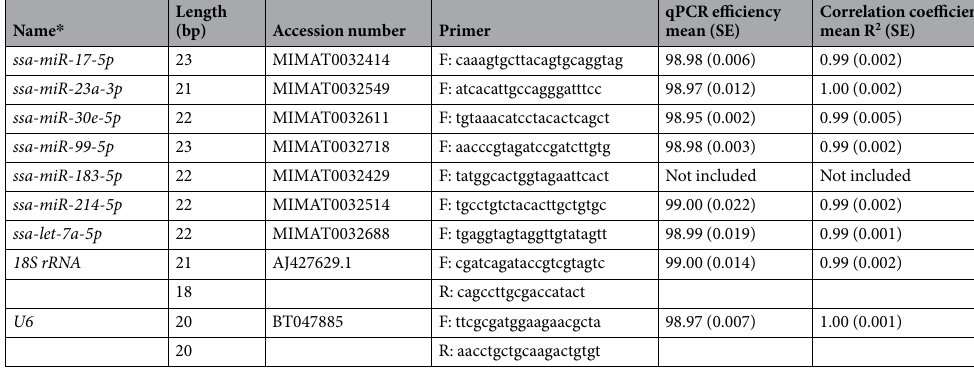
Table 1. Details of endongenous candidate reference genes. * MicroRNA names in accord with 50